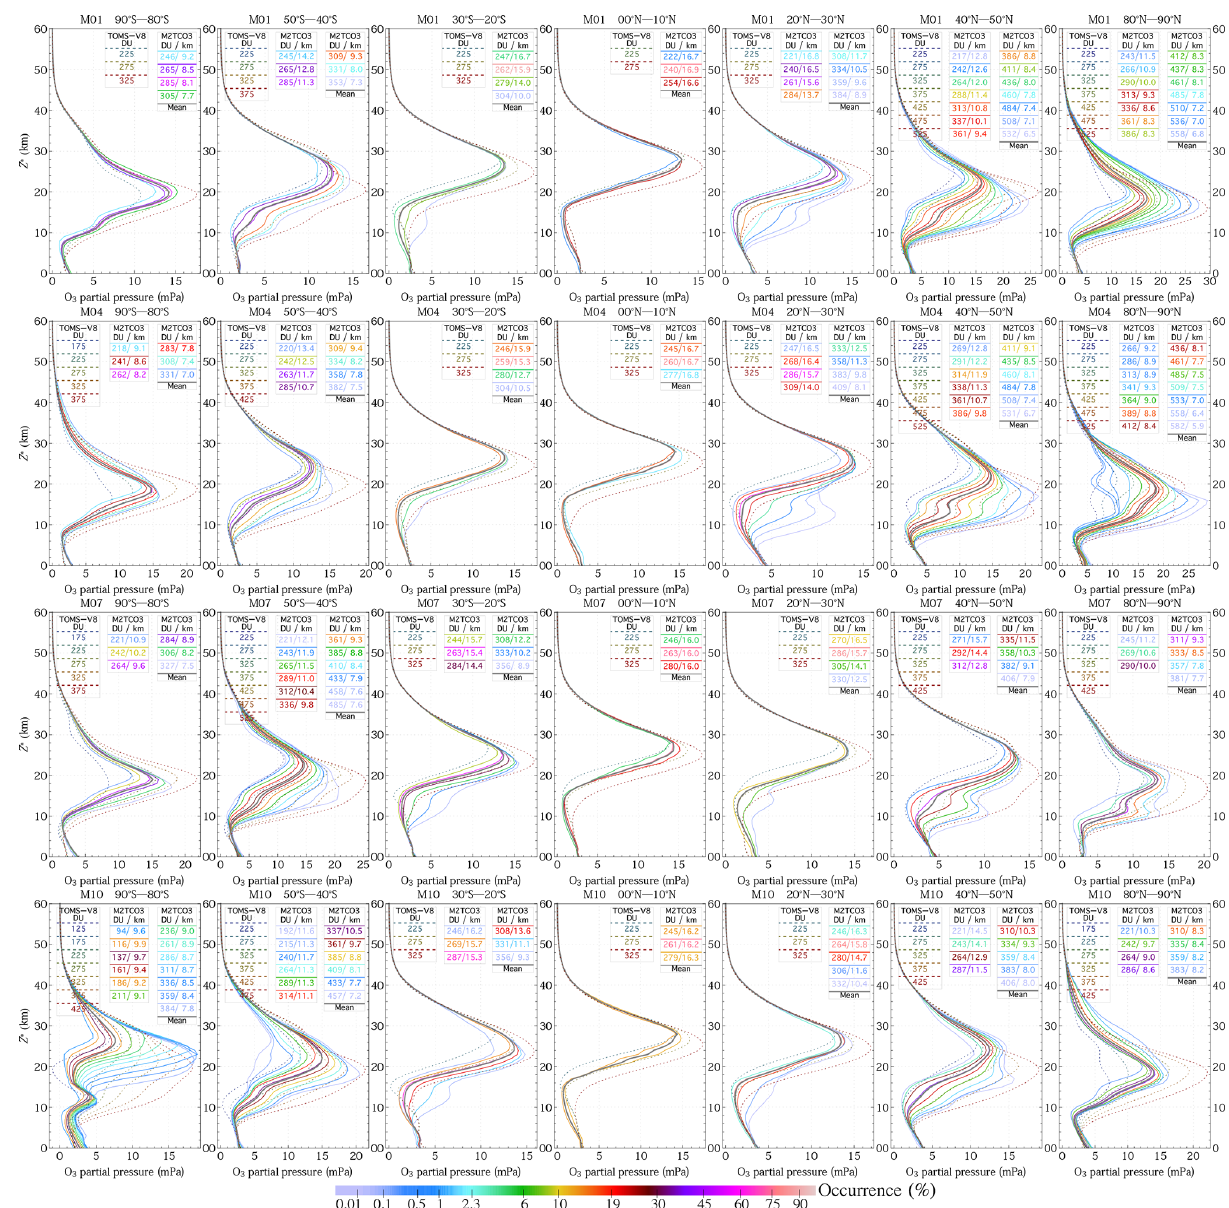
Figure 6. Profile comparisons between M2TCO3 and TOMS-V8 for four months and seven latitude zones (same as those in Fig. 4). Colored solid lines represent M2TCO3 profiles, while the dotted ones represent TOMS-V8 profiles. The color of a solid line indicates the percentage occurrence of the climatological profile, and its line legend displays the average tropopause altitude and the average total column O 3 . The solid gray line represents the downgraded M2TCO3 (monthly zonal mean) profile, which is the same as the downgraded M2TPO3 profile shown in Fig. 4. Note that since the total O 3 distribution is usually not symmetric with the bin center, the average total O 3 column does not change regularly from one bin to the next (see O 3 columns in the legends). On the other hand, TOMS-V8 profiles are created to cover preset (latitude-zone-dependent) O 3 column ranges in 50DU